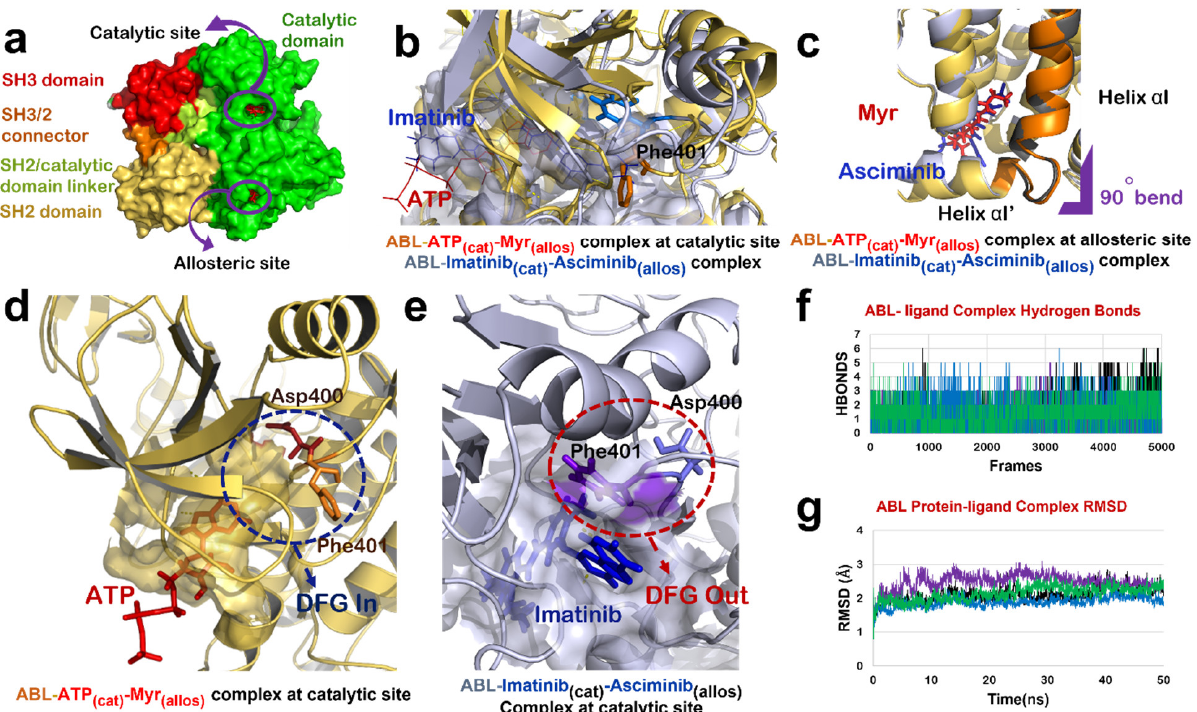
Figure 2. ABL-Imatinib (cat) -Asciminib (allos) Complex comparison with ABL-ATP-Myr complex. ( a ) Different domains of ABL protein in chain-A of 1OPL PDB structure; catalytic domain (green), SH3/2 connector (orange), SH2 domain (yellow) and SH3 domain (red). ( b ) Superimposed structure of catalytic site of ABL-ATP-Myr complex (ABL in yellow, ATP in red) and ABL-Imatinib (cat) -Asciminib (allos) (ABL in grey, Imatinib in blue). ( c ) Superimposed structure of allosteric site of ABL-ATP-Myr complex (ABL in yellow, Myr in red) and ABL-Imatinib (cat) -Asciminib (allos) complex (ABL in grey, Asciminib in blue), 90◦ bend highlighted by purple mark is induced by both Myr and Asciminib followed by formation of 4 residues αI’ helix. ( d ) DFG-‘in’ conformation of motif as induced by binding of natural substrate, ATP, at the catalytic site of ABL protein. ( e ) Molecular action mechanism of change in conformation of DFG motif induced by Imatinib at the catalytic site of ABL protein. ( f ) Hydrogen bonds plot of number of interactions formed by protein-ligand complexes, ABL-Imatinib (cat) -Asciminib (allos) complex (black), ABL-Wi-A (cat) -Wi-N (allos) complex (purple), ABL-Wi-A (cat) -Wi-A (allos) complex (blue) and ABL-Imatinib (cat) -Wi-A (allos) (green). ( g ) RMSD plot of protein-ligand complexes, ABL-Imatinib (cat) -Asciminib (allos) complex (black), ABL-Wi-A (cat) -Wi-N (allos) complex (purple), ABL-Wi-A (cat) -Wi-A (allos) complex (blue) and ABL-Imatinib (cat) -Wi-A (allos)